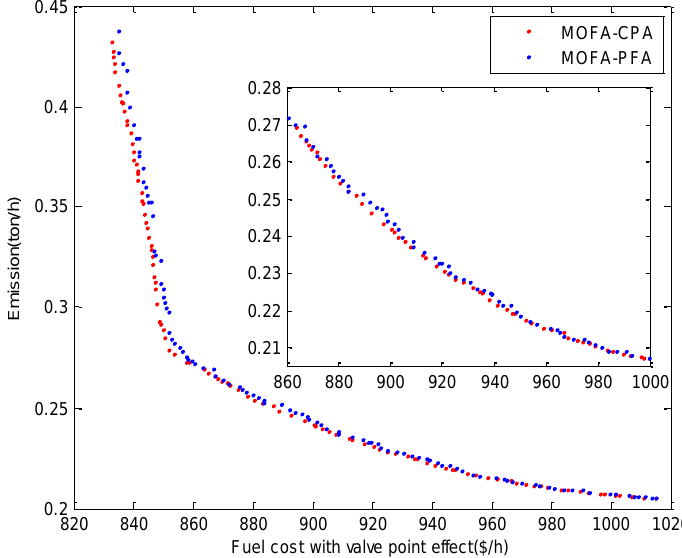
Figure 3. PFs obtained by MOFA-CPA and MOFA-PFA for Case 3.